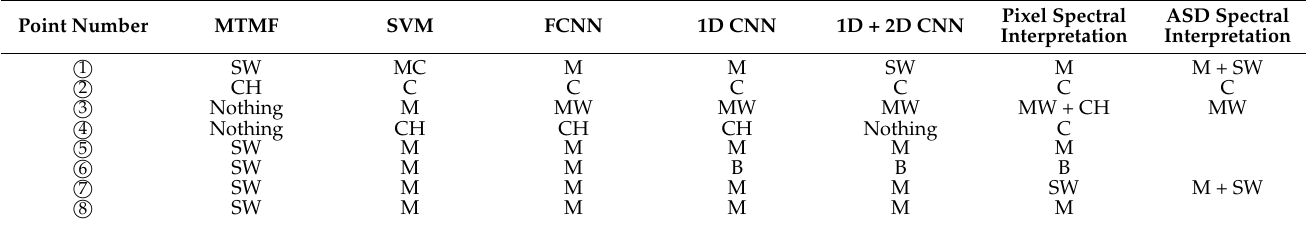
Table 6. A comparison table of the verification point results shown in Figure